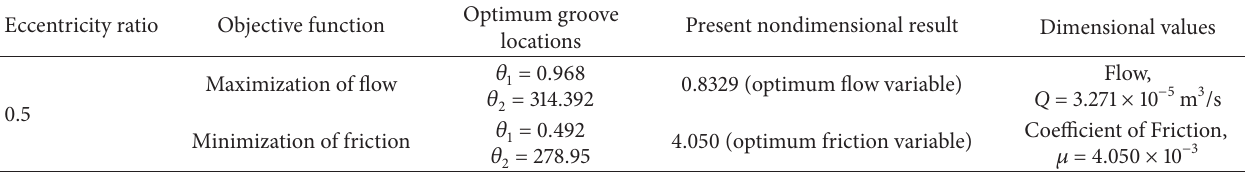
Table 8: Conversion of nondimensional results to dimensional ones.